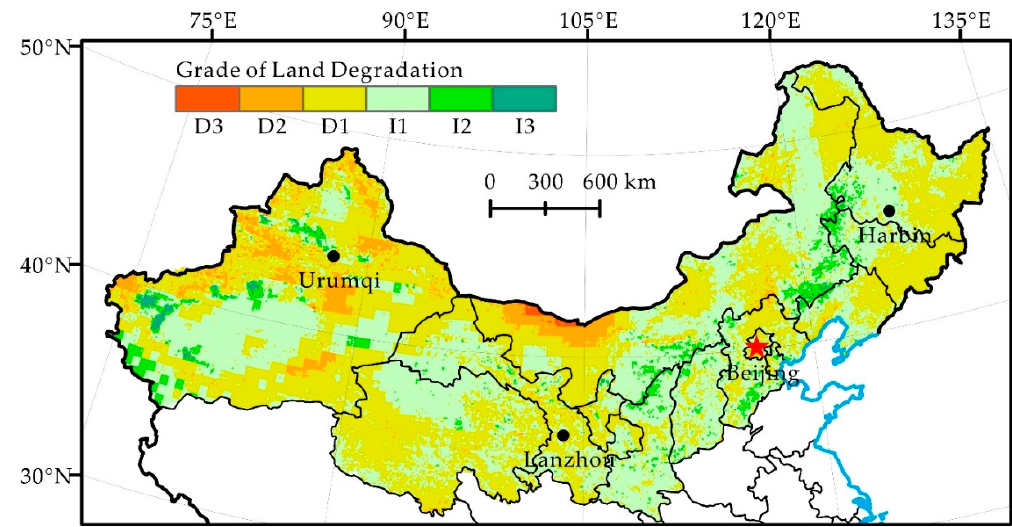
Figure 5. Distribution of Grade of Land Degradation during 1982–2000 in Northern China.